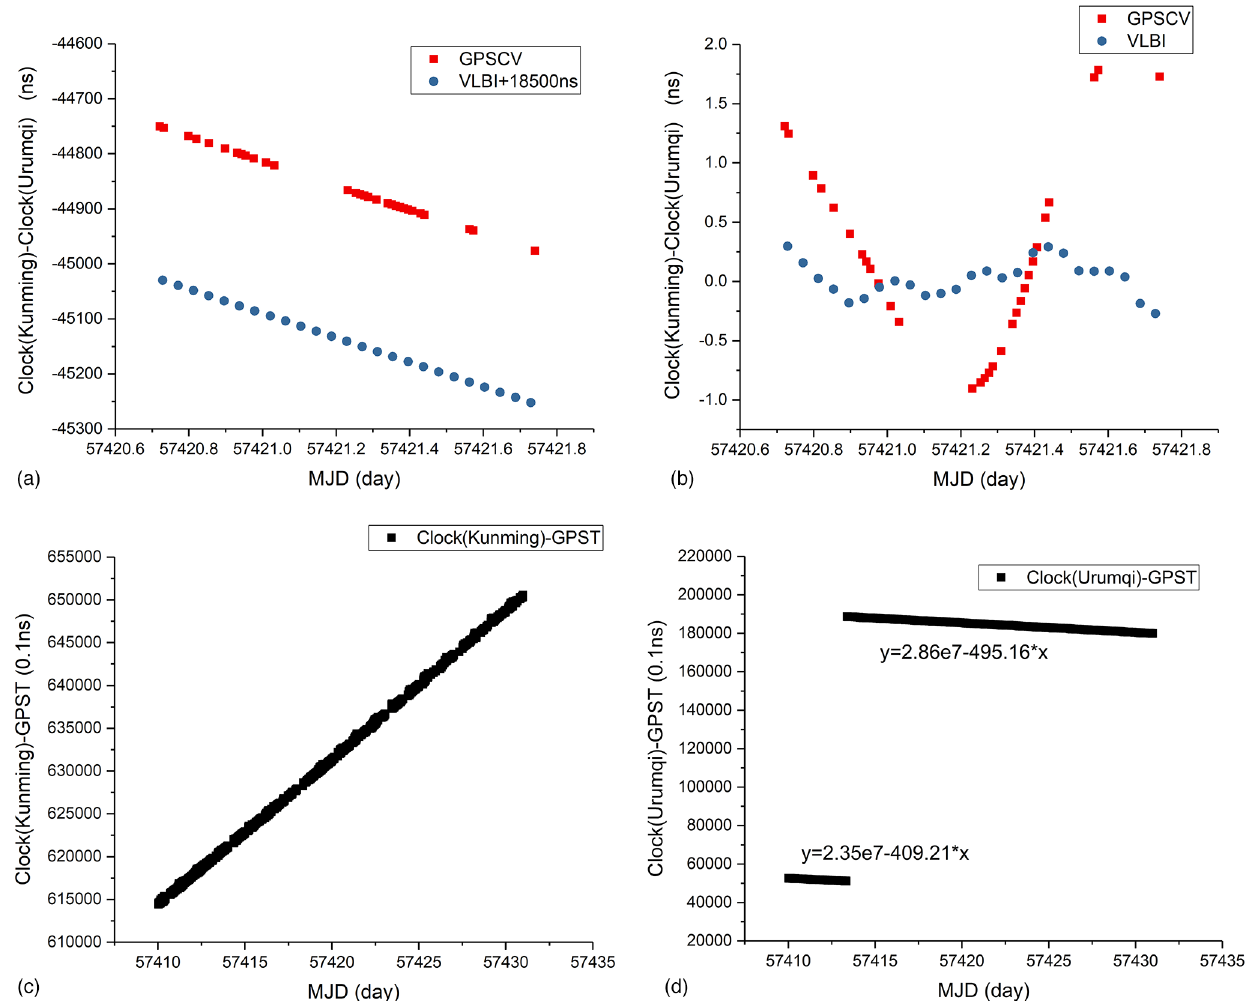
Fig. 5. Clock differences at the Kunming and Urumqi stations in MJD57420. (a) Clock differences calculations based on GPS CV and VLBI respectively. (b) Clock difference series after removing the linear trend. (c) Clock difference series between the Kunming station clock and GPST across 20 days surrounding MJD57420. (d) Clock difference series between the Urumqi station clock and GPST across 20 days surrounding